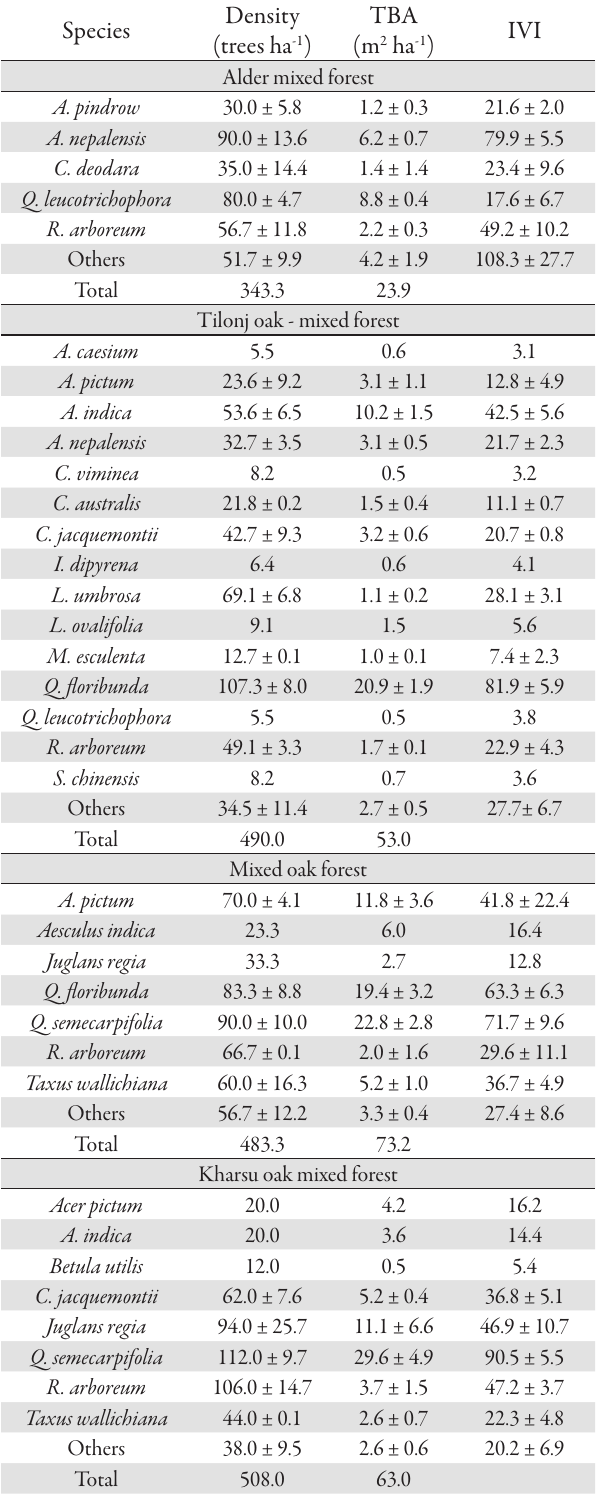
Tab. 1. Density, Total Basal Area (TBA) and Importance Value Index (IVI) of different species in different forest